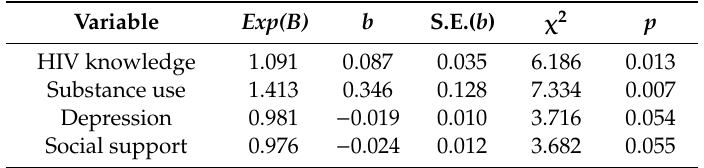
Table 1. Predicting HIV Testing Intentions: Logistic Regression Forward Selection—Final Model ( N =